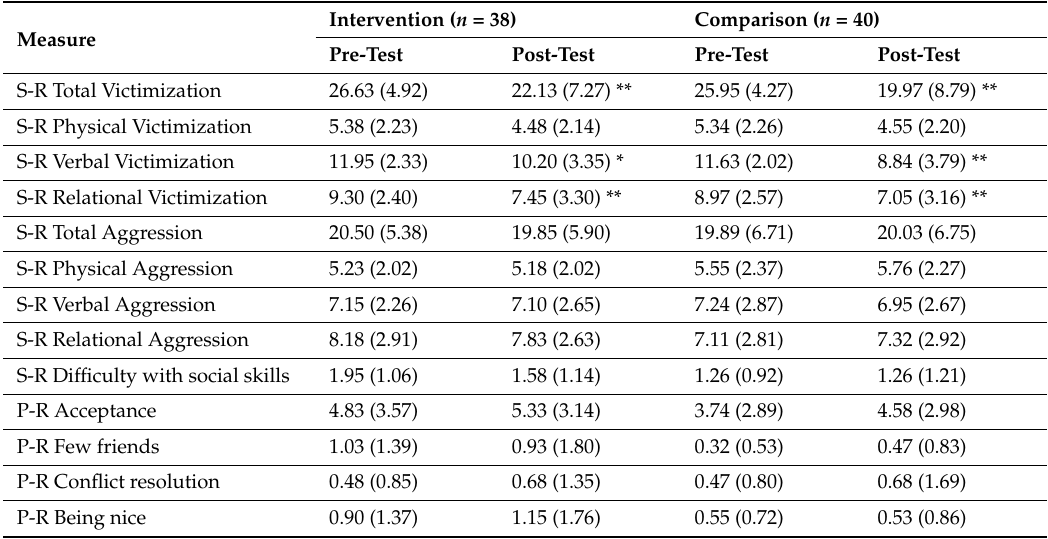
Table 1. Comparison between groups (intervention and comparison) with regard to pre-test and post-test using Poisson regression